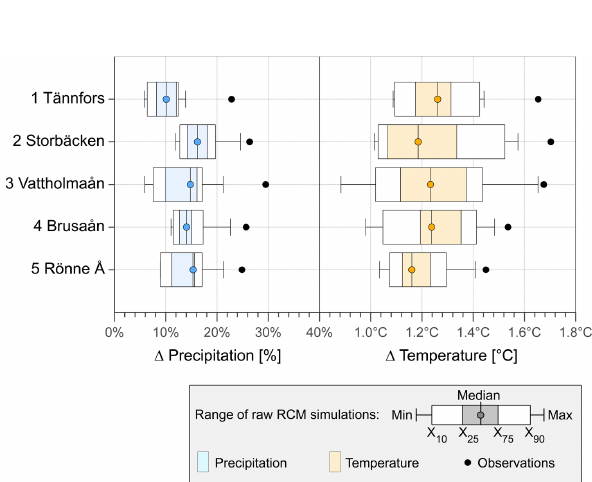
Fig. 4. Differences between mean values of the two constructed sub- sets for precipitation (left) and temperature (right) shown for raw RCM simulations (colored boxes) and observations (black